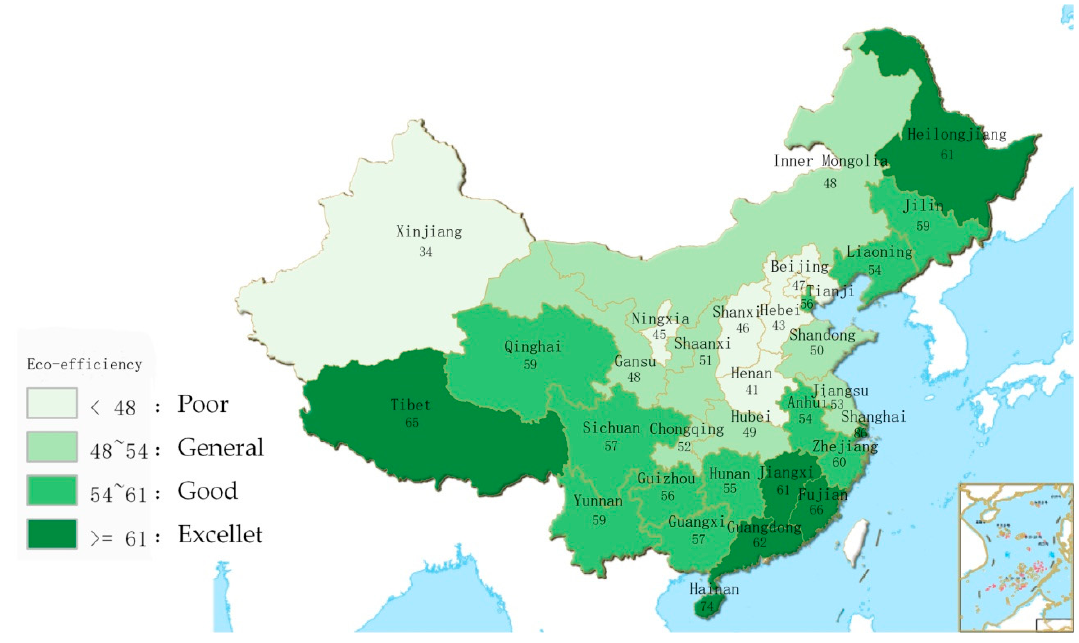
Figure 2. The mean scale results of eco-efficiency for the provincial regions in China.